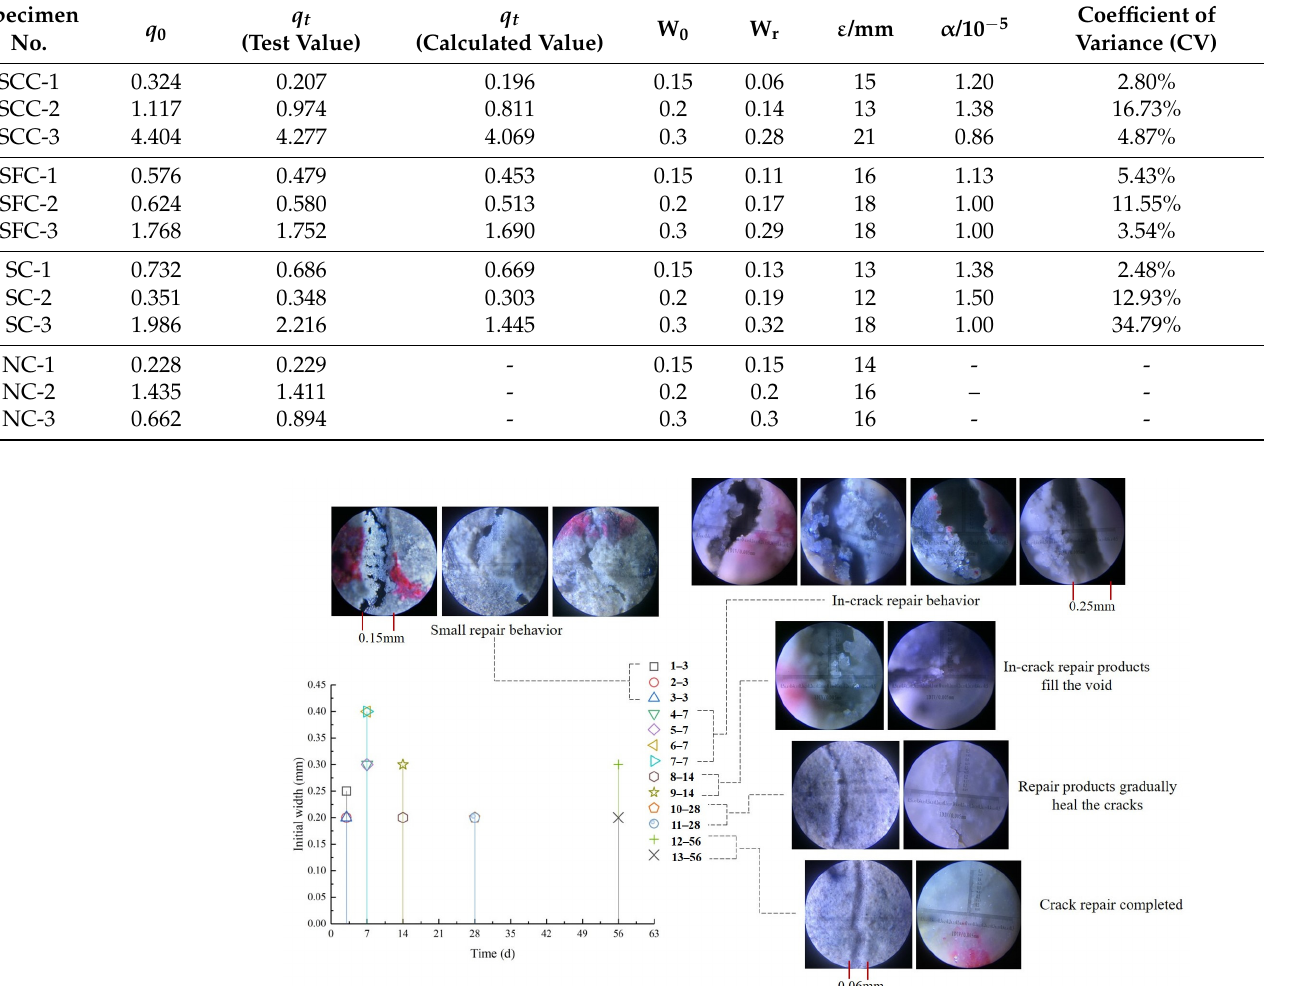
Table 6. Comparison between calculated and tested values of water flux of repaired 14-day speci- mens/(L/h).